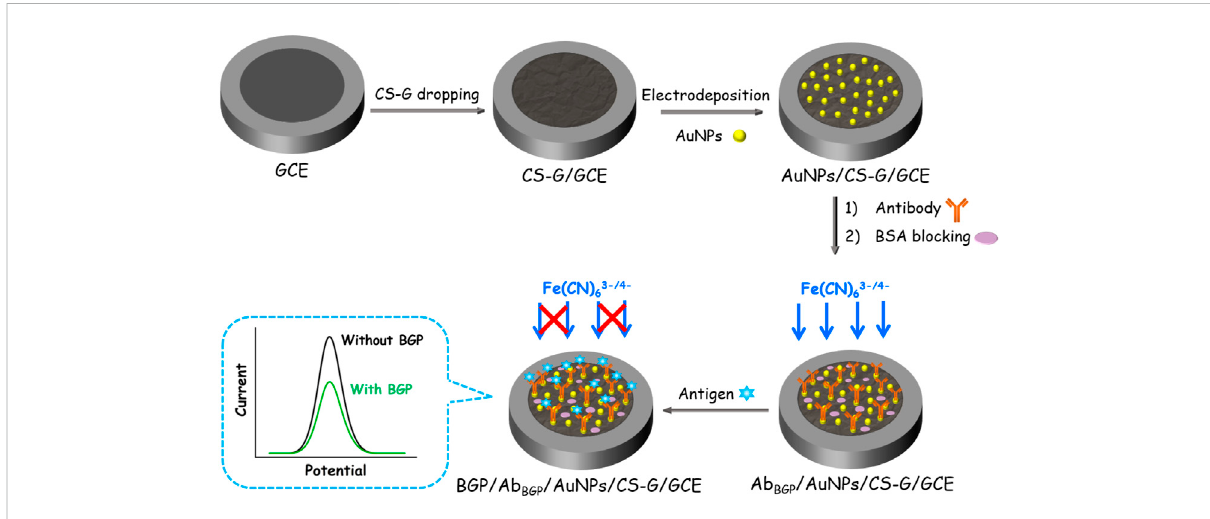
Schematic illustration for the simple fabrication of immunoanalysis interface and the following electrochemical detection of